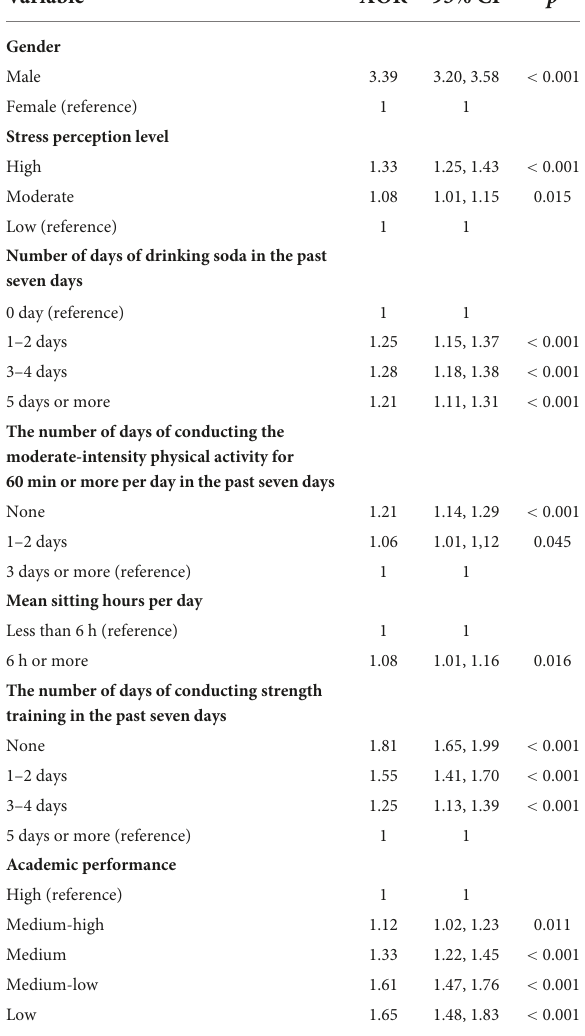
TABLE 2 Predictors for obesity in South Korean adolescents: aOR and 95% CI. Variable